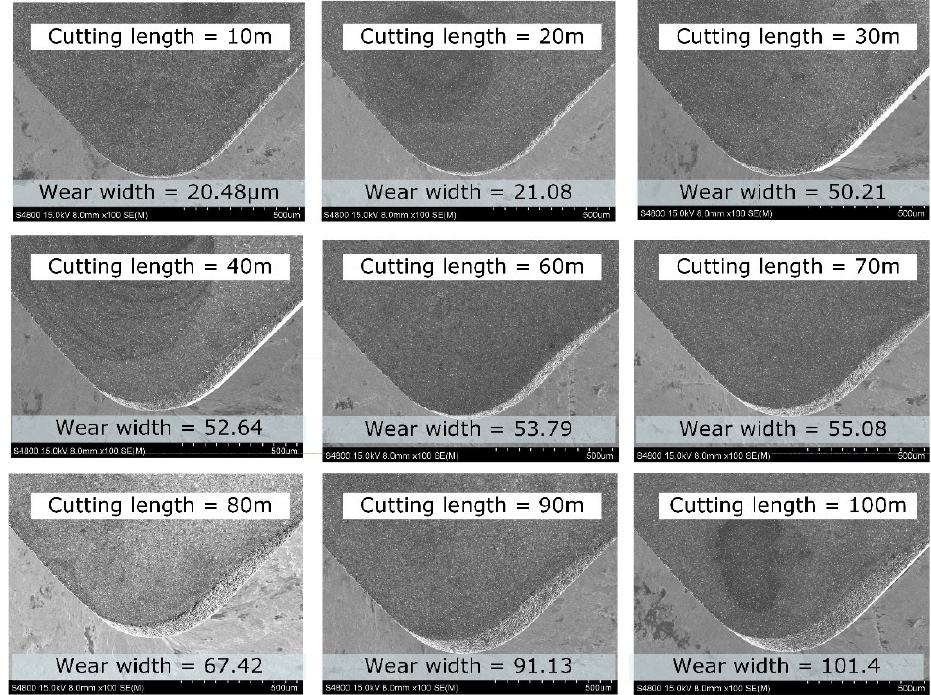
Figure 6. rake face wear width at different cutting lengths. Figure 6. Rake face wear width at different cutting